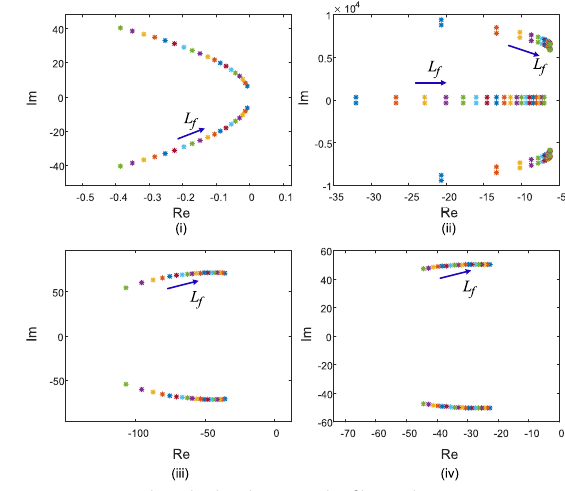
Fig. 11 Eigenvalue plot by changing the filter inductance (i) Droop (ii) VSM (iii) VOC (iv) VOC-PSO